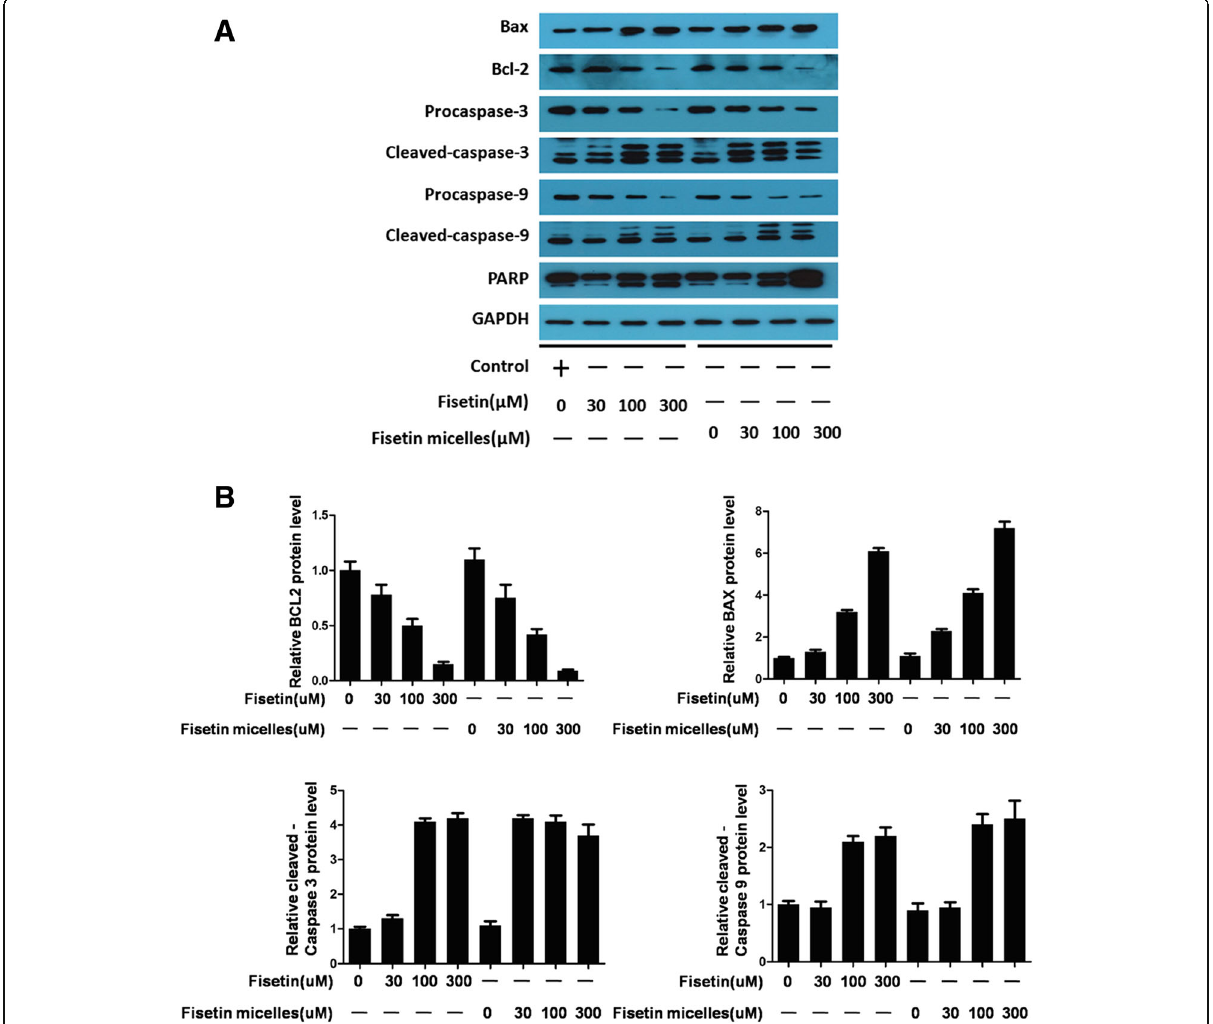
Fig. 4 Fisetin/fisetin micelles induce cell apoptosis through mitochondrial pathway. Fisetin/fisetin micelles inducecaspase activation and imbalance of Bax/Bcl-2 in treated SKOV3 cells. a Cells treated with different concentrations of fisetin for 24 h, meanwhile, at the same electric lane, sample from SKOV3 cells treated with the same concentration of fisetin micelles were loaded. DMSO (< 0.1%) diluted in saline was considered as control. GAPDH was used as a loading control. b Densitometric analysis was performed for Bcl-2, Bax, Cleaved-caspase-9 and Cleaved-caspase-3. Values were normalized to GAPDH. P < 0.05 compared to